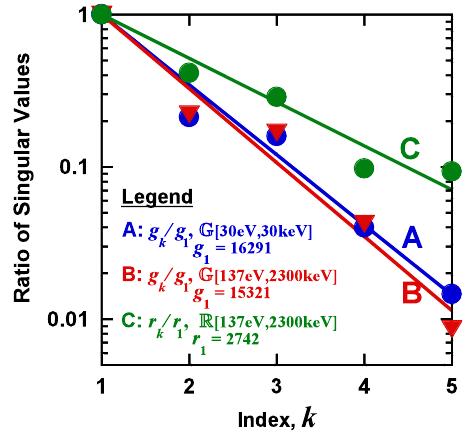
FIG. 6. Ratios of singular values (SV’s) for the Gram matrix G and response matrix R . The points labeled A (blue) and B (red) =g , of G evaluated over intervals, [30 eV, are the SV ratios, g k 1 30 keV] and [137 eV, 2300 eV], respectively, while points C are =r , of R for [137 eV, 2300 eV]. The legend the SV ratios, r k 1